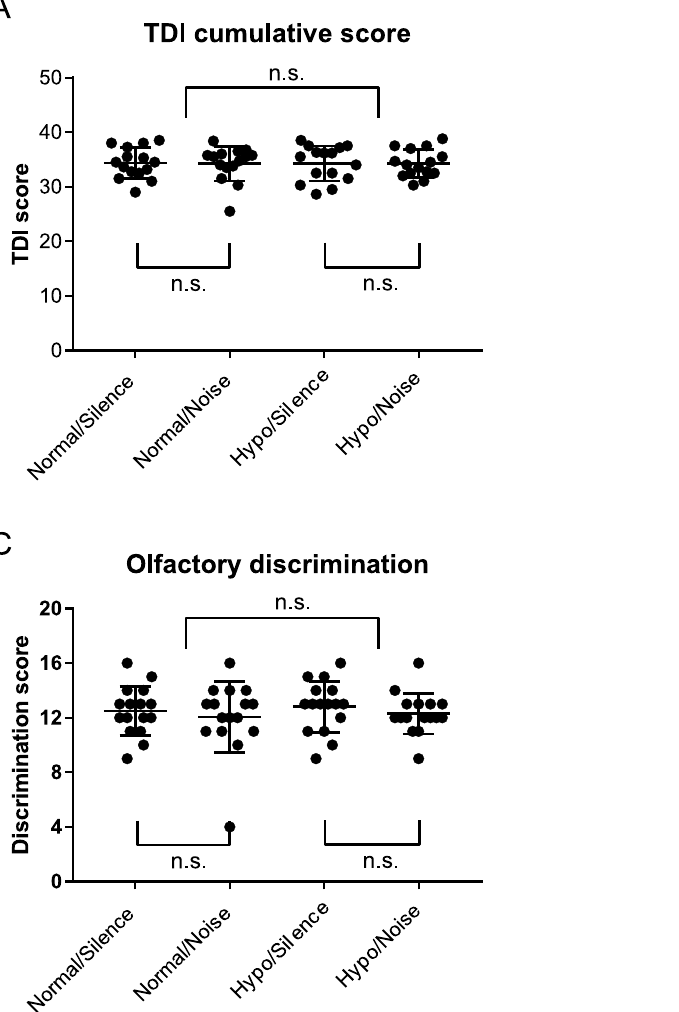
PLOS ONE | https://doi.org/10.1371/journal.pone.0190837 January 25,